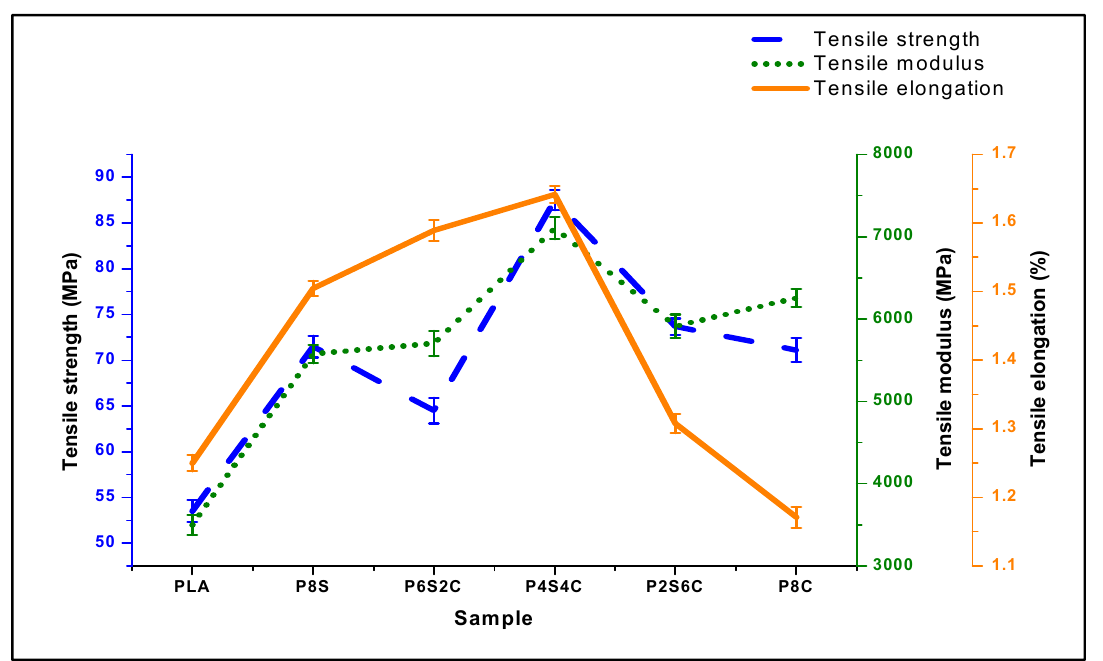
Figure 9. Tensile strength, modulus, and elongation of neat PLA and biocomposite. The biocomposite’s tensile strength was significantly greater than that of the neat PLA (53.5 MPa). However, the graph indicates that PC8 and PC6S2 have lower values due